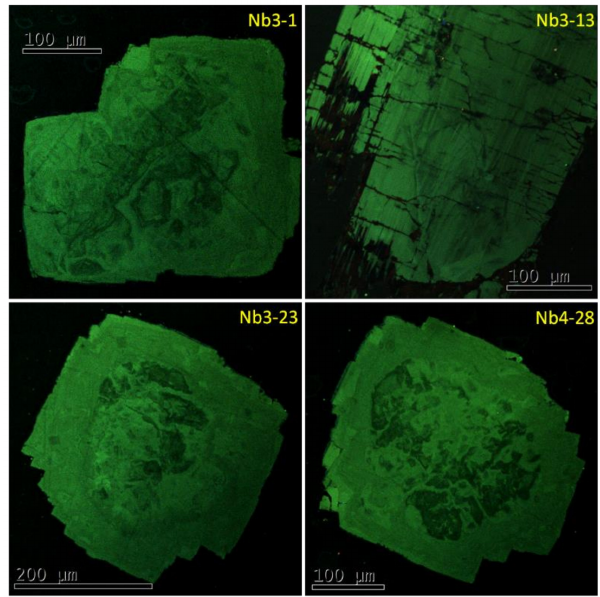
Figure 8. Cathodoluminescence images of rippite crystals.